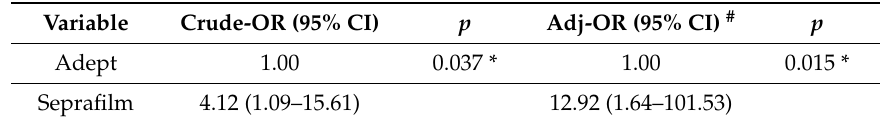
Table 5. Hazard ratio of postcesarean metritis.